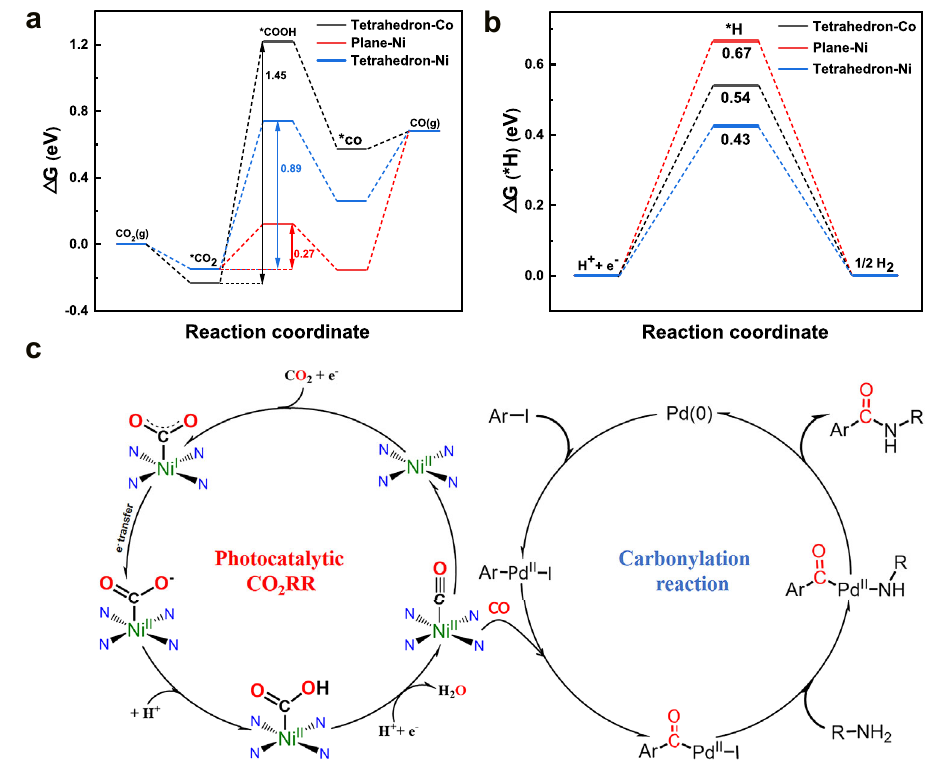
Fig. 5 DFT calculations were performed to understand the effects of different con fi gurations on the photoreduction of CO 2 . a Free energy diagram of CO 2 RR toward the production of CO. b Free energy pro fi le of HER. c The possible reaction mechanism of the tandem